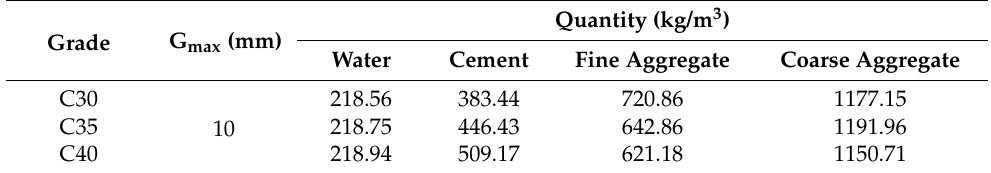
Table 1. Mixture proportion of the concrete.